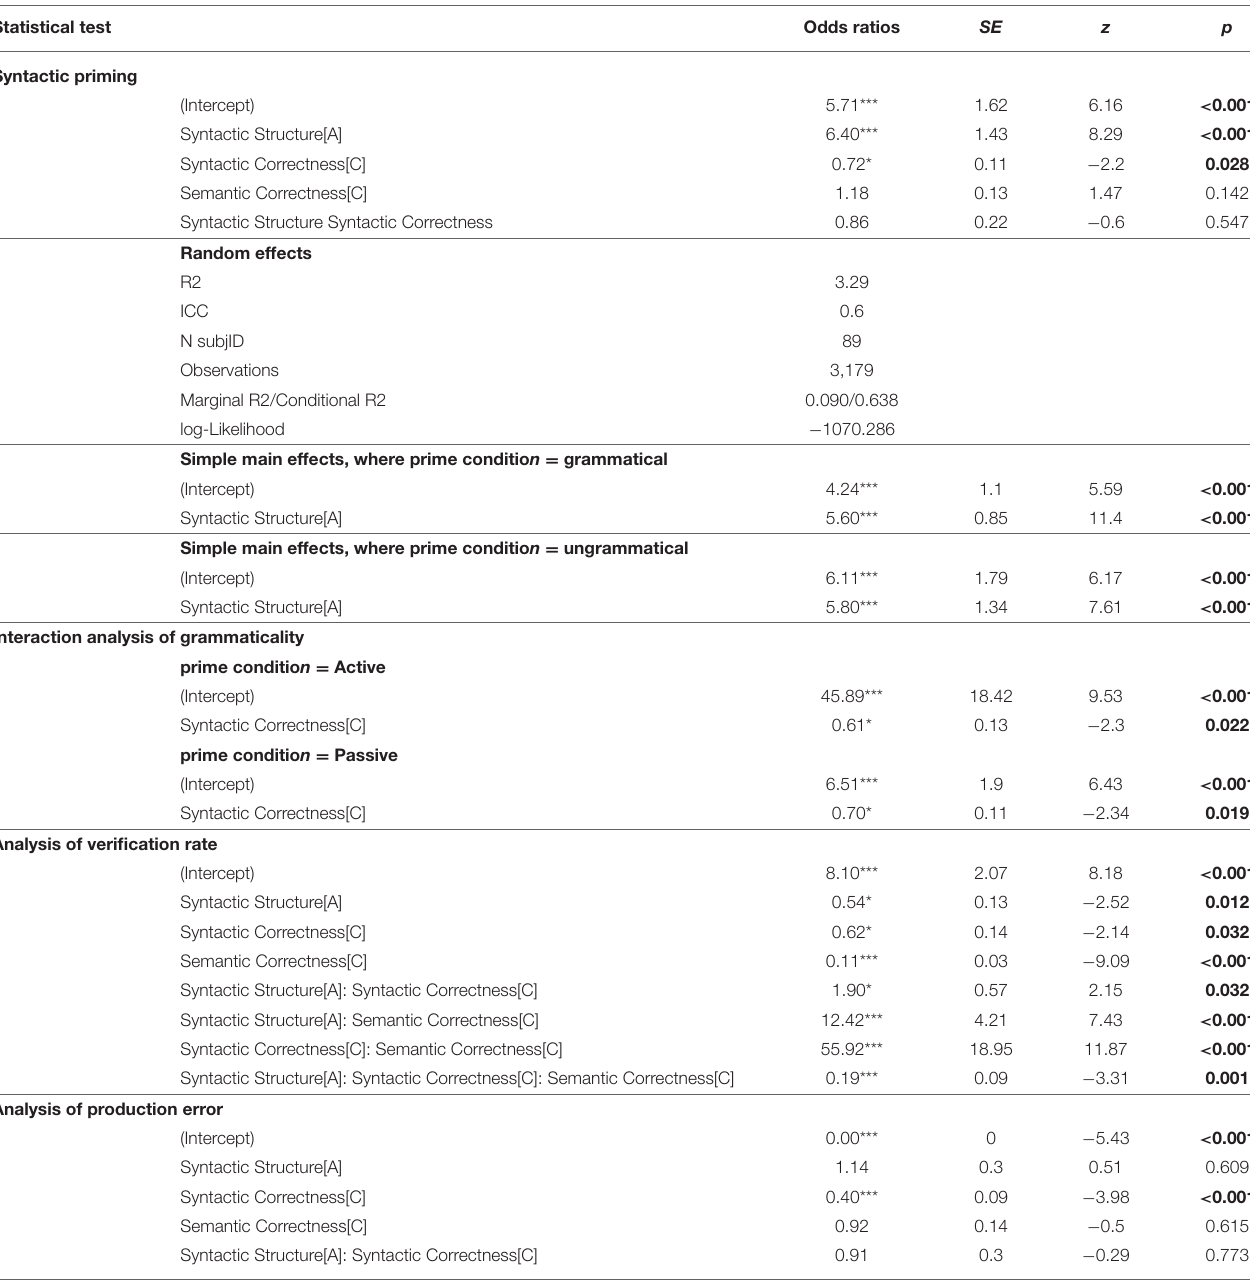
TABLE 4.1 | Logistic fixed effects model coefficients and statistical tests from experiment 1. Statistical